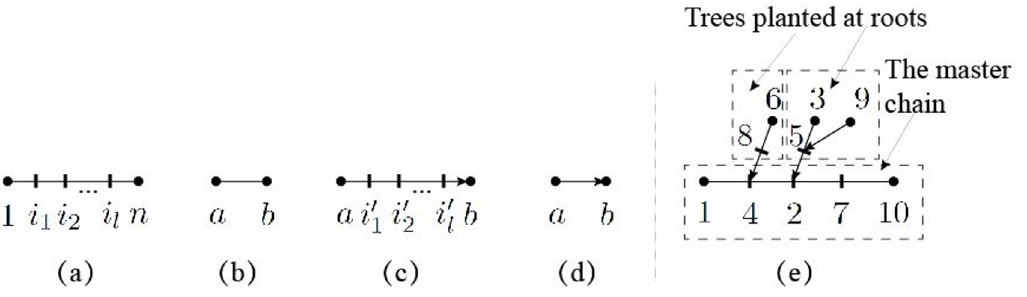
· . . . · F i · (cid:15) n . 1 l . A chain 1 · (cid:15) n . . . · F · 2 k b . The a · F i 0 i 0 1 l 2 k . A full graph is a · b